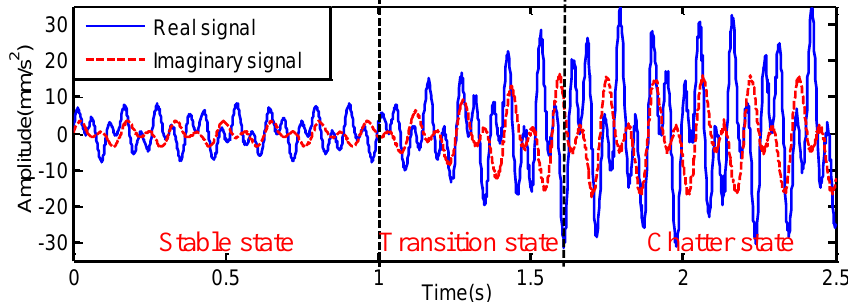
Figure 3. Complex-valued chatter signal generated by chatter generation system.